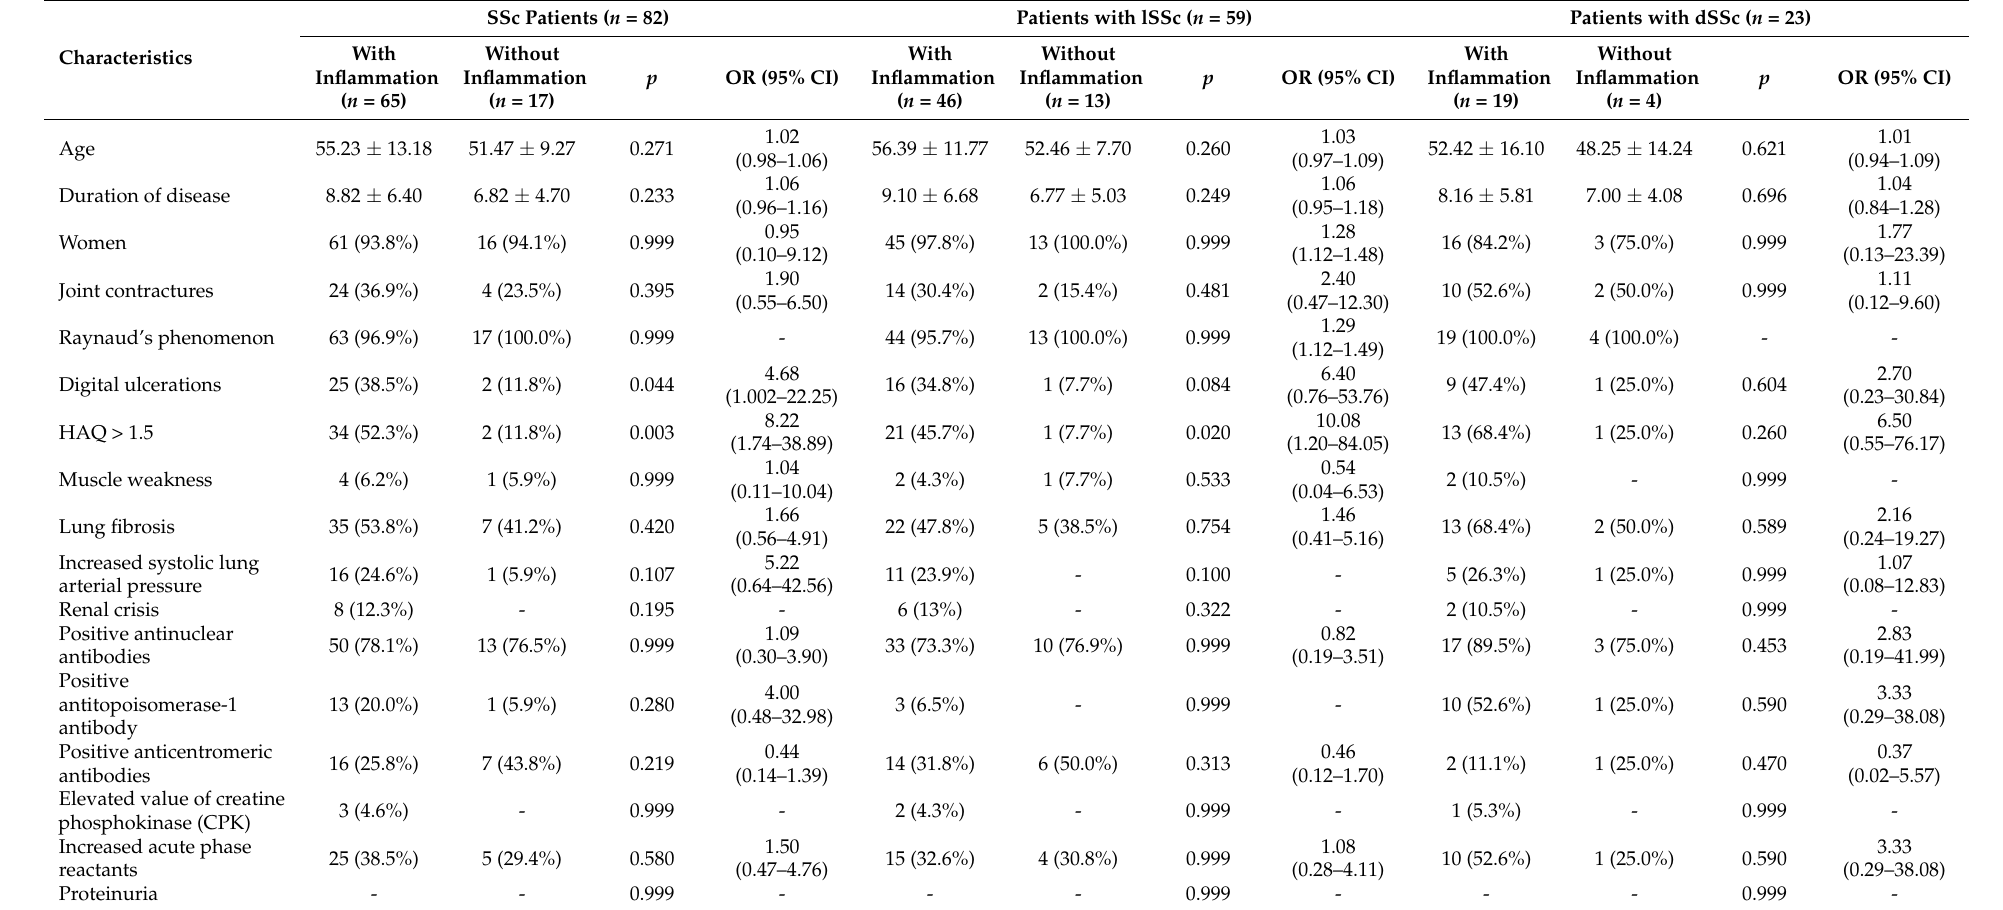
Table 8. Characteristics of the disease in SSC patients depending on the presence of MRI-detected